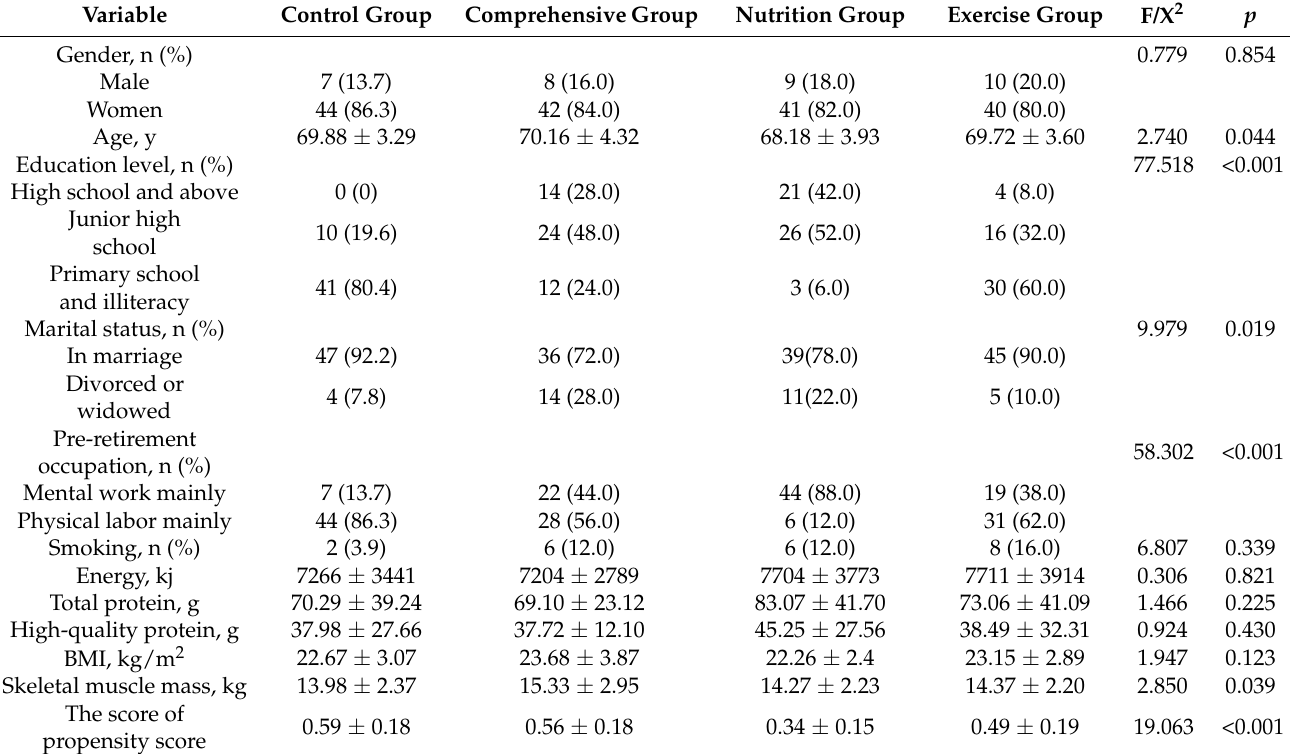
Table 2. Basic information of participants in each